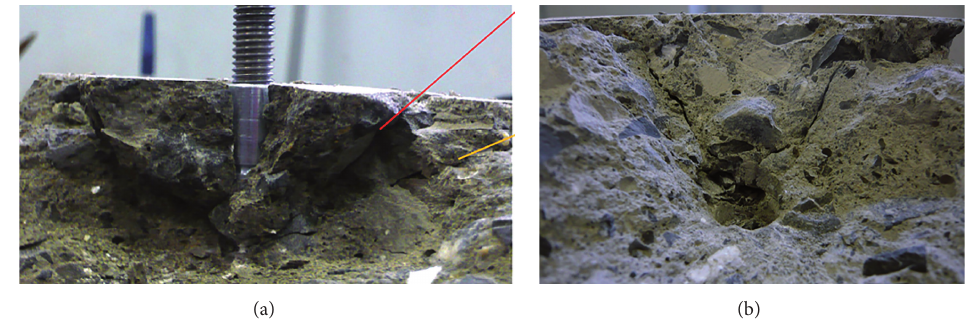
Figure 6: Concrete cone extracted by the B15G sleeve; (a) initial tensile crack of Figure 1(a) and fracture surface of Figure 1(c); (b) opposite side of the cracked specimen.